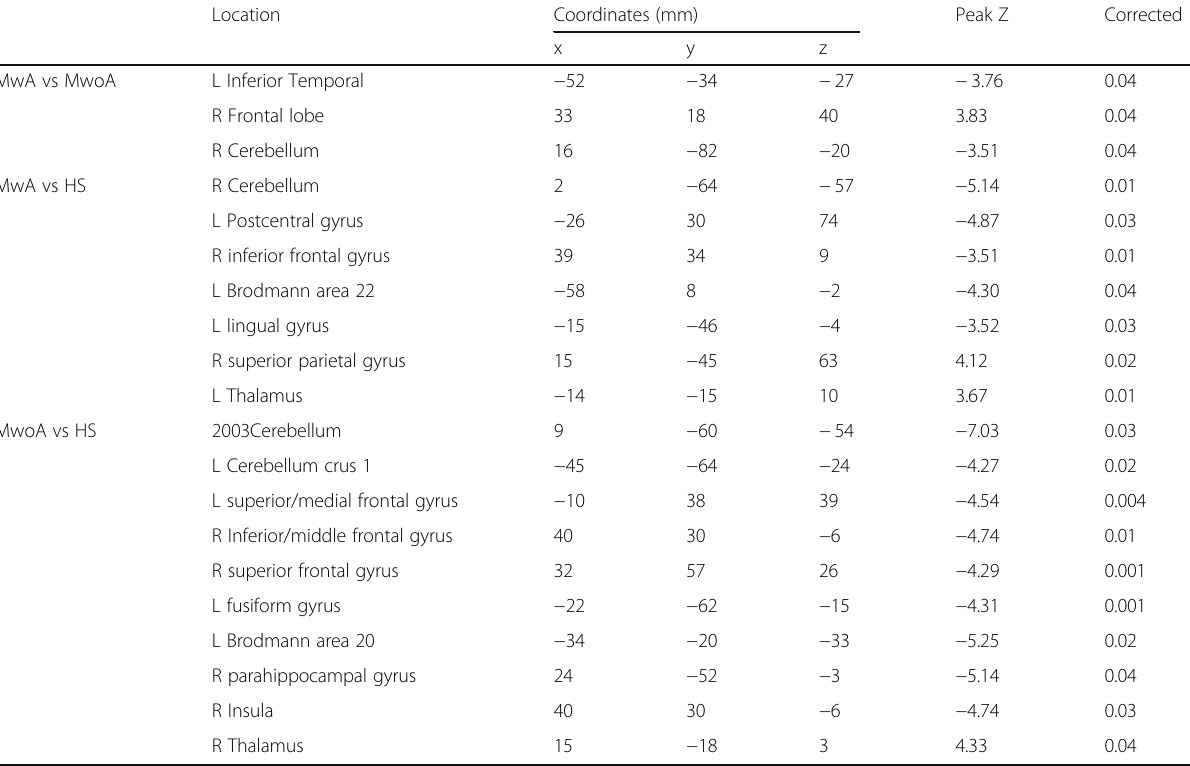
Table 2 Significant regions with less or more grey matter volume in migraine patients compared with controls